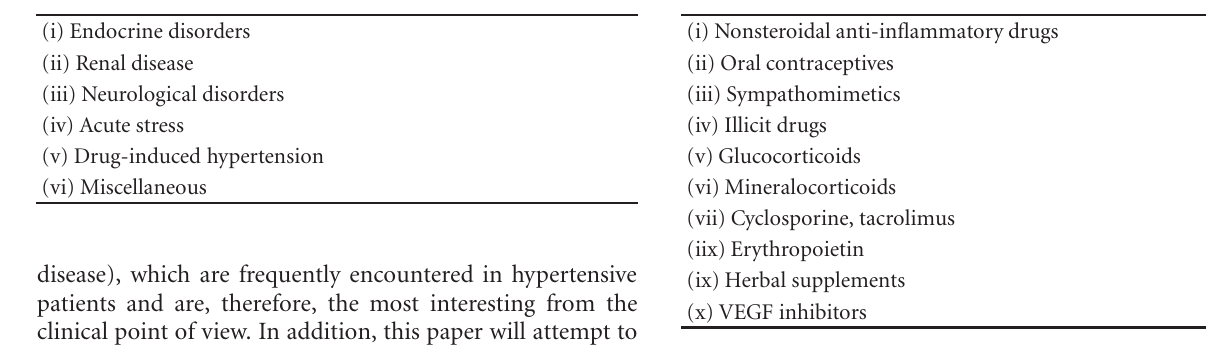
Table 1: Secondary forms of hypertension (disease categories). Table 2: Drugs inducing or exacerbating